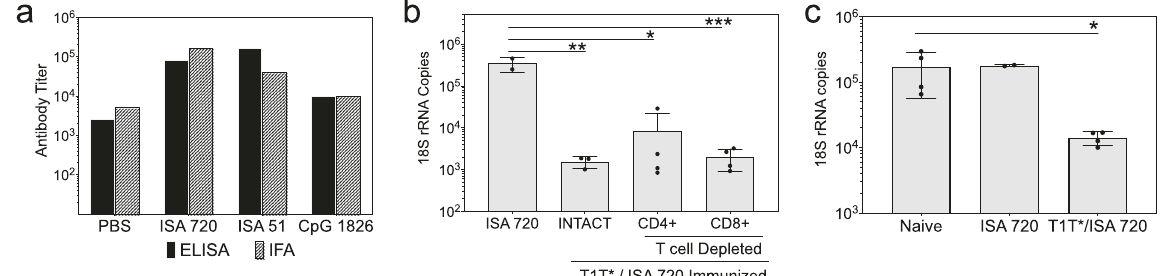
Fig. 4 Linear peptides containing minor repeats elicit sporozoite-neutralizing antibodies. a C57BL/6 mice were immunized with three doses of linear T1T* peptide without adjuvant (PBS), or with adjuvant comprised of oil-in-water emulsions (ISA 720, ISA 51) or a TLR 9 agonist CpG. Pooled sera were tested against repeat peptide by ELISA or against P. falciparum sporozoites by IFA. b Mice immunized with three doses of T1T*/ISA 720 were challenged by exposure to the bites of PfPb-infected mosquitoes. A subset of immunized mice were treated with MAB speci fi c for CD4 + or CD8 + T cells prior to challenge. Parasite 18 S rRNA copy numbers in liver extracts obtained 40 h post-challenge were measured by qRT-PCR. Bars show 18 S rRNA copy number mean ± SD and individual mice are shown as circles. There was a statistically signi fi cant decrease in parasite 18 S rRNA copy numbers in all peptide-immunized groups compared to adjuvant only control (one-way ANOVA log-transformed values with Tukey ’ s test, adjusted ** P = 0.0012, * P = 0.0019, *** P = 0.0010). The difference in parasite rRNA copy number between intact and CD4 + or CD8 + T-cell-depleted mice was not statistically signi fi cant (one-way ANOVA log-transformed values with Tukey ’ s test, adjusted P = 0.8511 and P = 0.9967, respectively. c Pooled immune serum obtained post 3rd dose of T1T*/ISA 720 was passively transferred by i.v. injection to naïve recipients prior to challenge by exposure to the bites of PfPb-infected mosquitoes. Control mice received pooled sera from naïve mice or mice immunized with ISA 720 adjuvant only. Due to limited supply, only two mice received serum from mice immunized with ISA 720 adjuvant only. Parasite 18 S rRNA copy numbers in liver extracts obtained 40 h post-challenge were measured by qRT-PCR. Results shown as 18 S rRNA copy number mean ± SD with individual mice shown as closed circles. Recipients of T1T*/